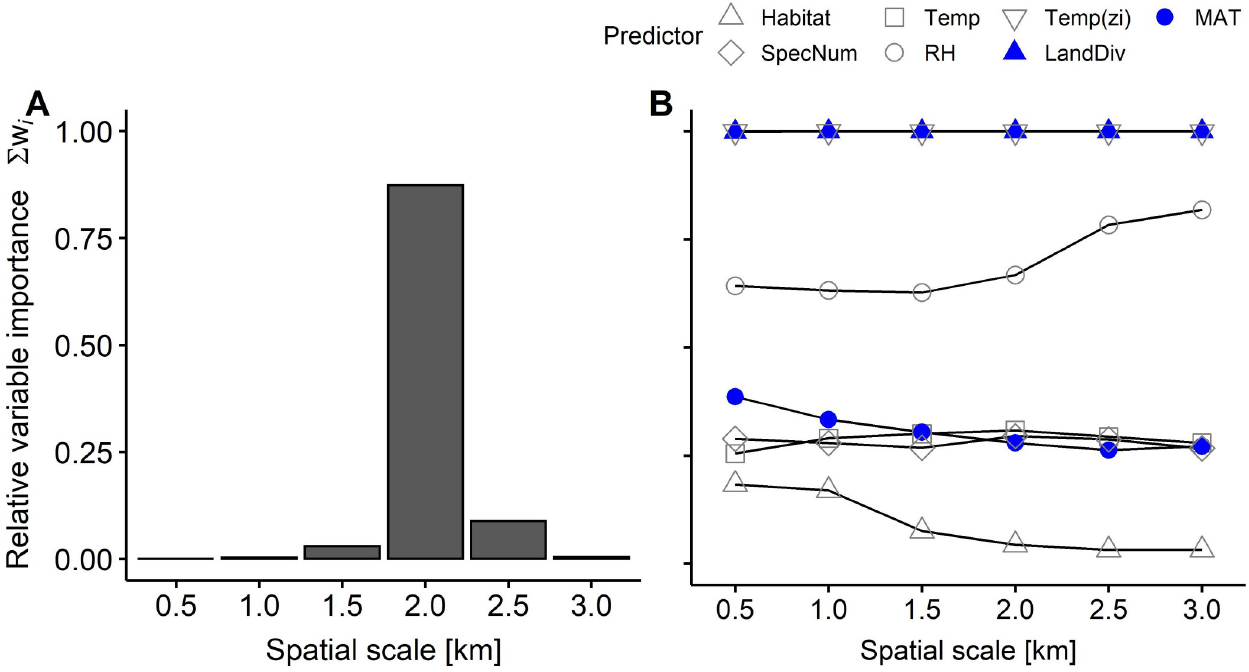
Fig 2. Relative importance (sum of Akaike weights) for explaining arthropod predation rates of A) spatial scale (i.e. models with all possible predictor combinations at one scale relative to the others) and of B) each candidate predictor per spatial scale. White symbols refer to habitat characteristics (Habitat: habitat type, SpecNum: plant species richness, Temp or RH: local mean temperature or mean relative humidity during artificial caterpillar exposure, zi: included as zero-inflation term) and filled blue symbols to regional factors (LandDiv: landscape diversity, MAT: multi-annual mean temperature). Landscape diversity is the only landscape parameter (value changes with spatial